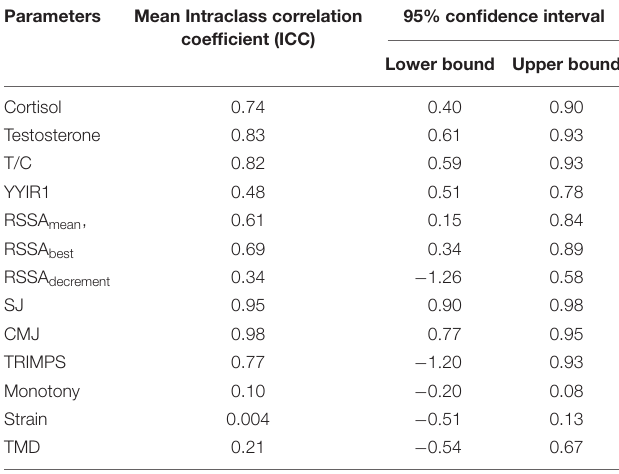
TABLE 2 | Intraclass correlation coefficients.